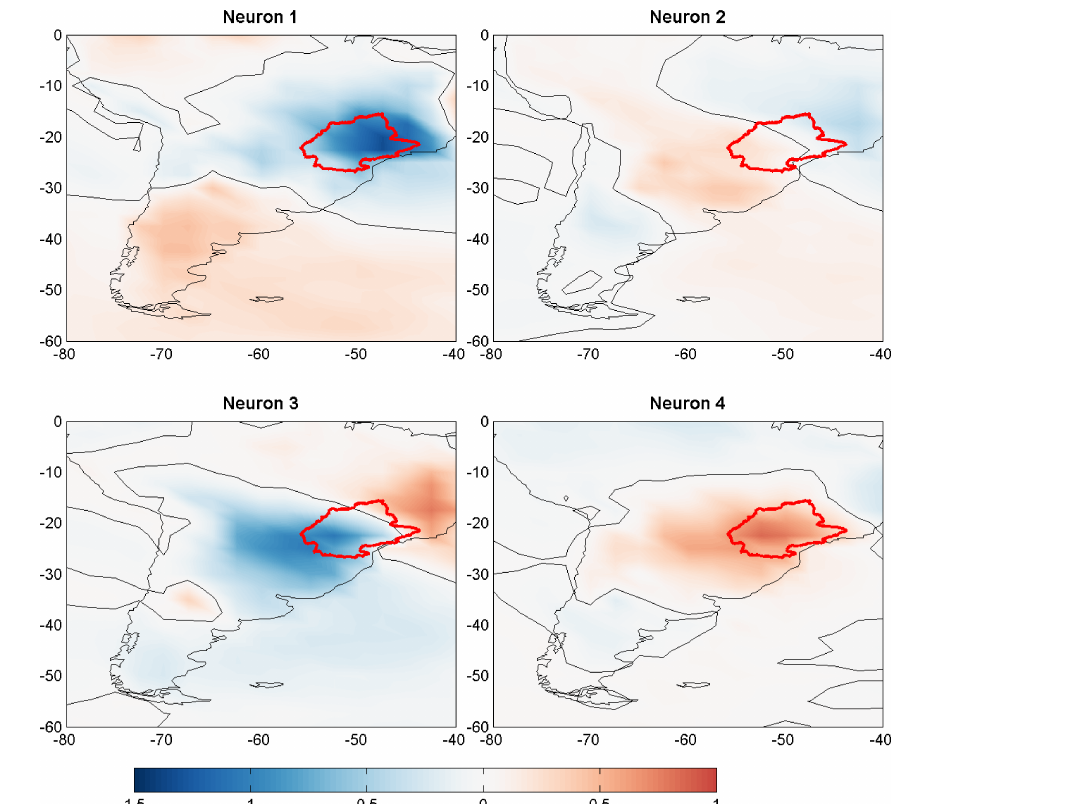
Figure 7. Anomalies ( ◦ C) in the near-surface air temperature averaged over each neuron class. The red contour line shows the Upper Paraná River basin. The zero contour line is also